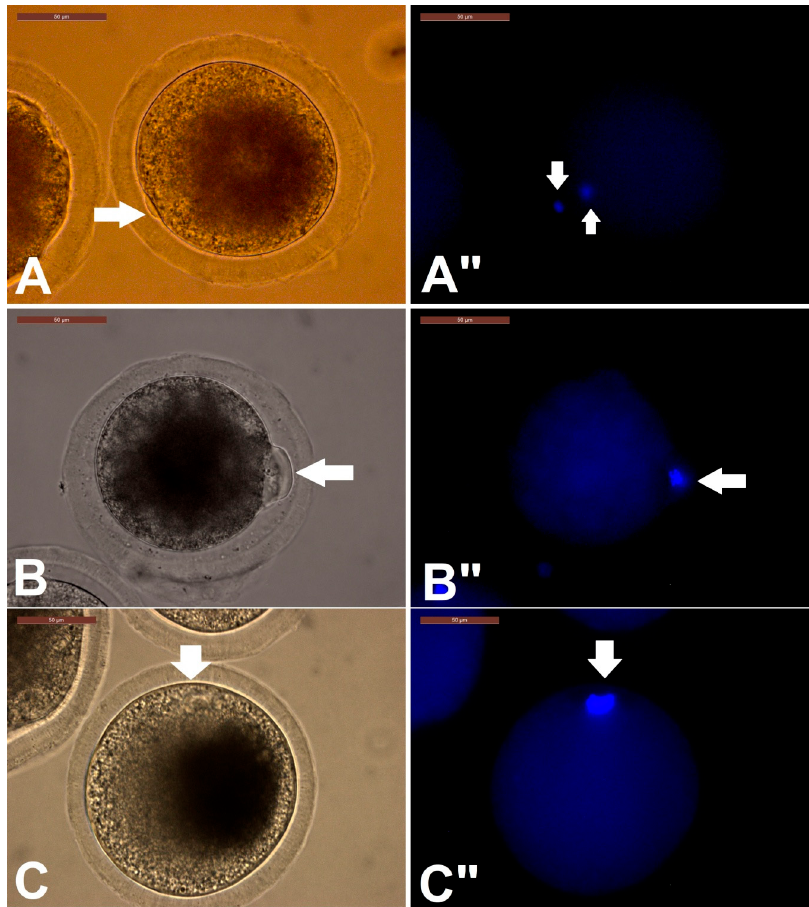
Figure 3. Patterns of nuclear maturation after biphasic IVM. First polar body extrusion after biphasic IVM. Staining was done with Hoechst stain and visualized under fluorescence microscope. ( A ) First polar body extrusion and metaphase II oocyte. The arrow in A indicates a polar body and its location beside the metaphase II plate. ( A’’ ) is the corresponding fluorescent image of A. ( B ) Oocyte with large polar body, indicating impaired cytokinesis. ( B’’ ) is the corresponding fluorescent image of B. ( C ): Anaphase I. ( C” ) corresponding fluorescent image of C. Scale bar = 50 μ m.